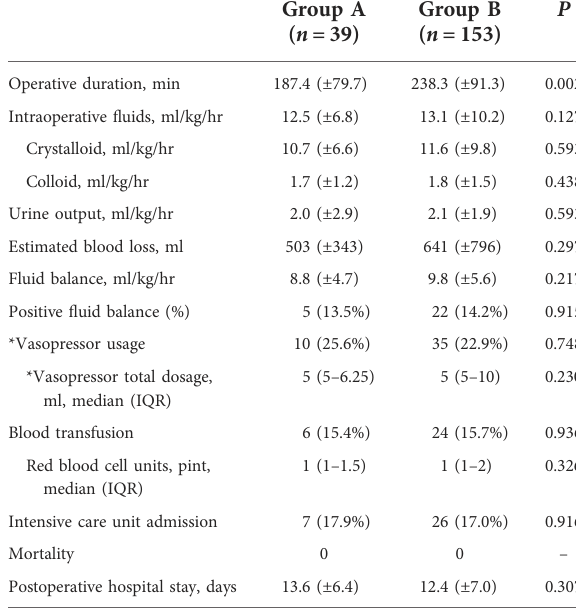
TABLE 2 Intraoperative and postoperative patient outcomes. TABLE 1 Clinico-demographic patient characteristics.